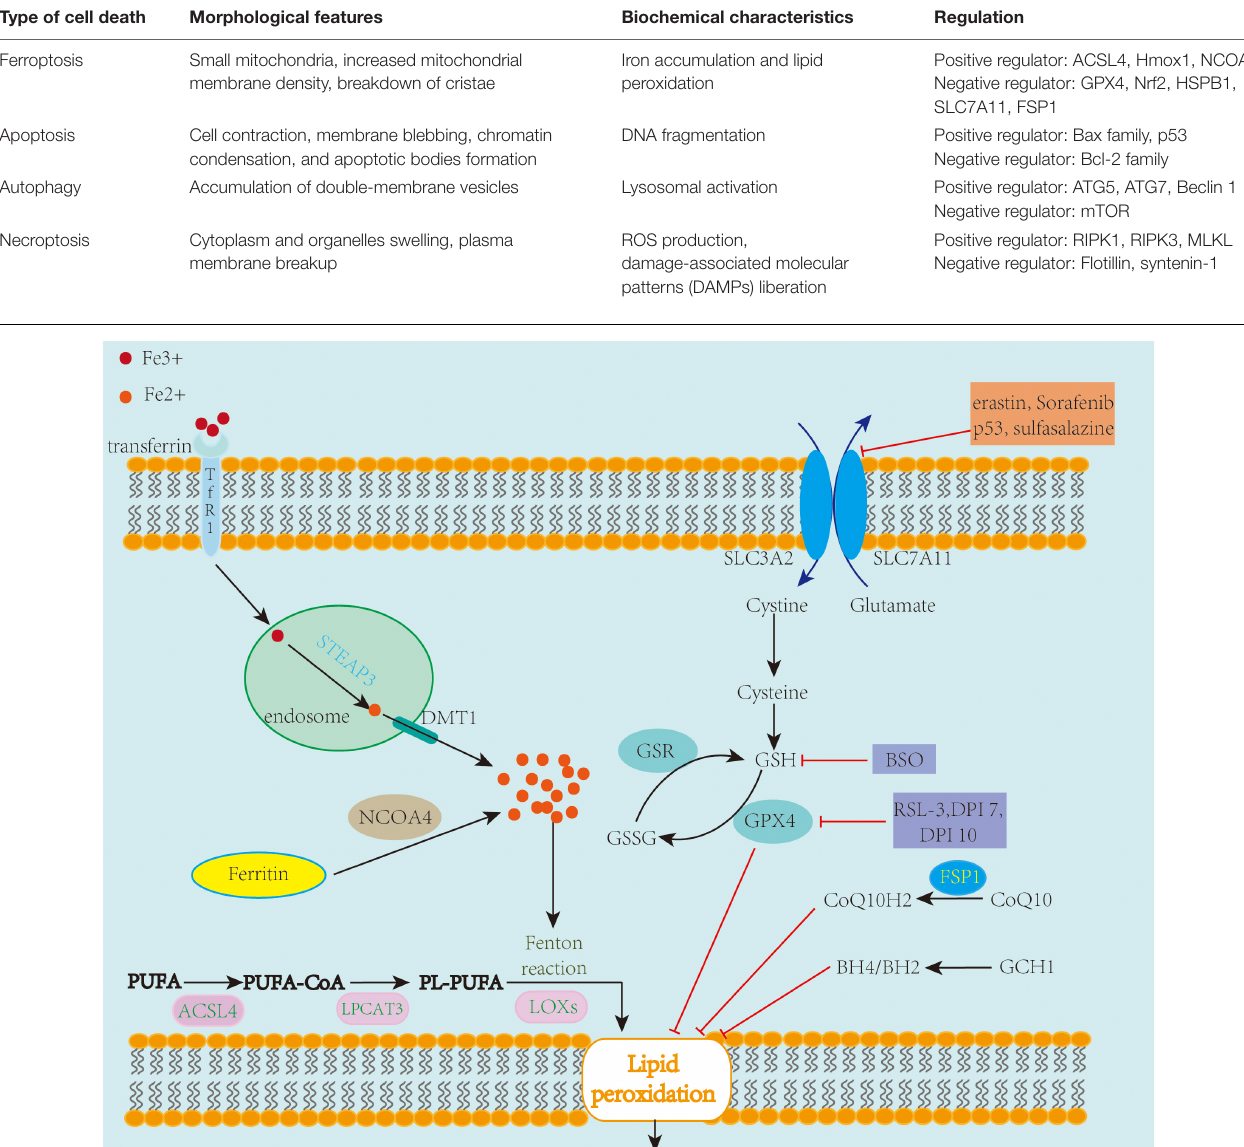
TABLE 1 | Characteristics of the different types of cell death.